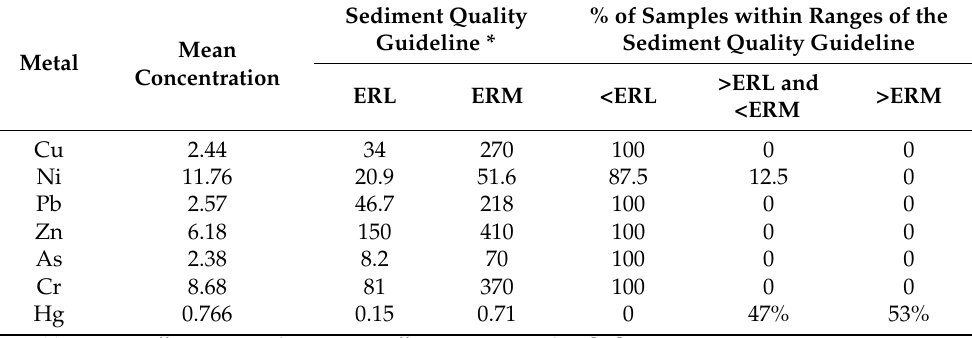
Table 4. Distribution of samples in the ranges established by the SQG, according to the PTE concen- trations (mg/kg).